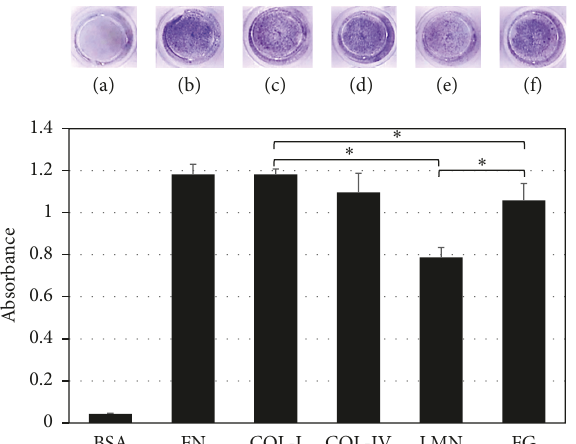
Figure 6: EXP-21 cells extracellular matrix (ECM) protein adhesion assay . Cell adhesion assay CytoSelect (cid:2) (Cell Biolabs) was employed to characterize cell attachment to ECM proteins like (b) fibronectin (FN), (c) type I-collagen (COL-I), (d) type IV-collagen (COL-IV), (e) laminin (LMN), (f) fibrinogen (FG). (a) Bovine serum albumin (BSA) is used as adhesion control. Attached cells after 1h were stained with Coomassie blue dye which was subsequently extracted to compare the absorbances. The lowest adhesion was obtained on LMN. Data shown are mean ± SD of three independent experiments in duplicate ( 𝑛 = 6 ). Asterisks show significant differences ( 𝑝 < 0.05 ).